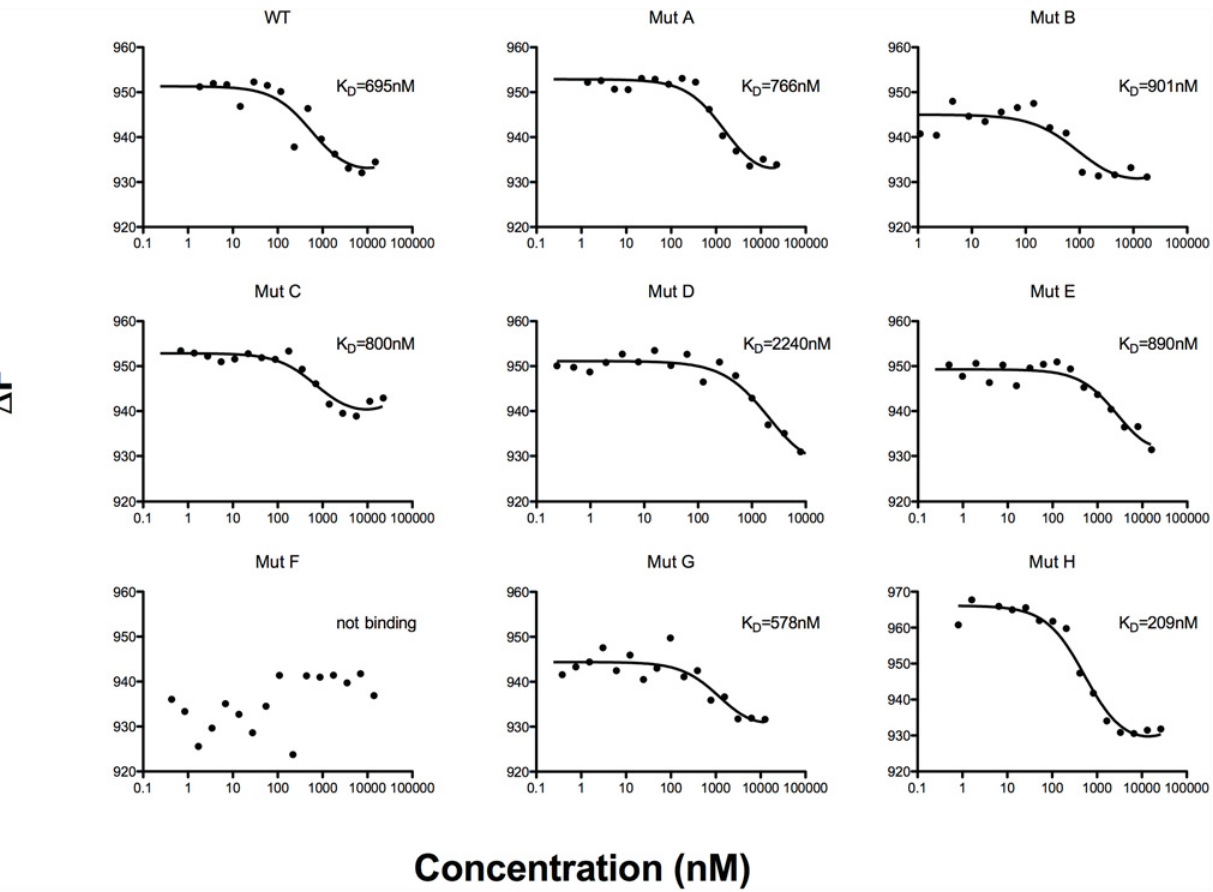
Fig 4. Mutated proteins binding and affinity to Heparin-FITC. Affinity of the mutated recombinant proteins for the ligand heparin was tested by microscale thermophoresis. Heparin FITC was kept at constant concentration of 100 nM while proteins were tested at ranging concentration varying between 0.5 to 60000 nM. Measurements were performed at 50% LED power and MST 60. Results were plotted using GraphPad Prism and K D calculated using NanoTemper analysis software (Table 1).